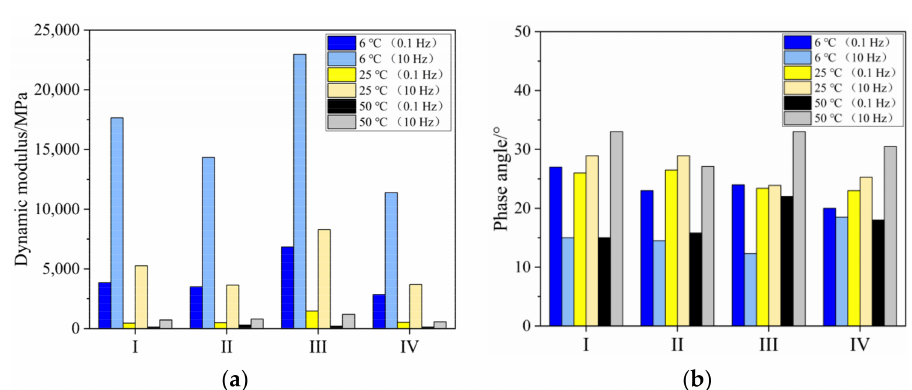
Figure 13. Test results of dynamic modulus. ( a ) Dynamic modulus. ( b ) Phase